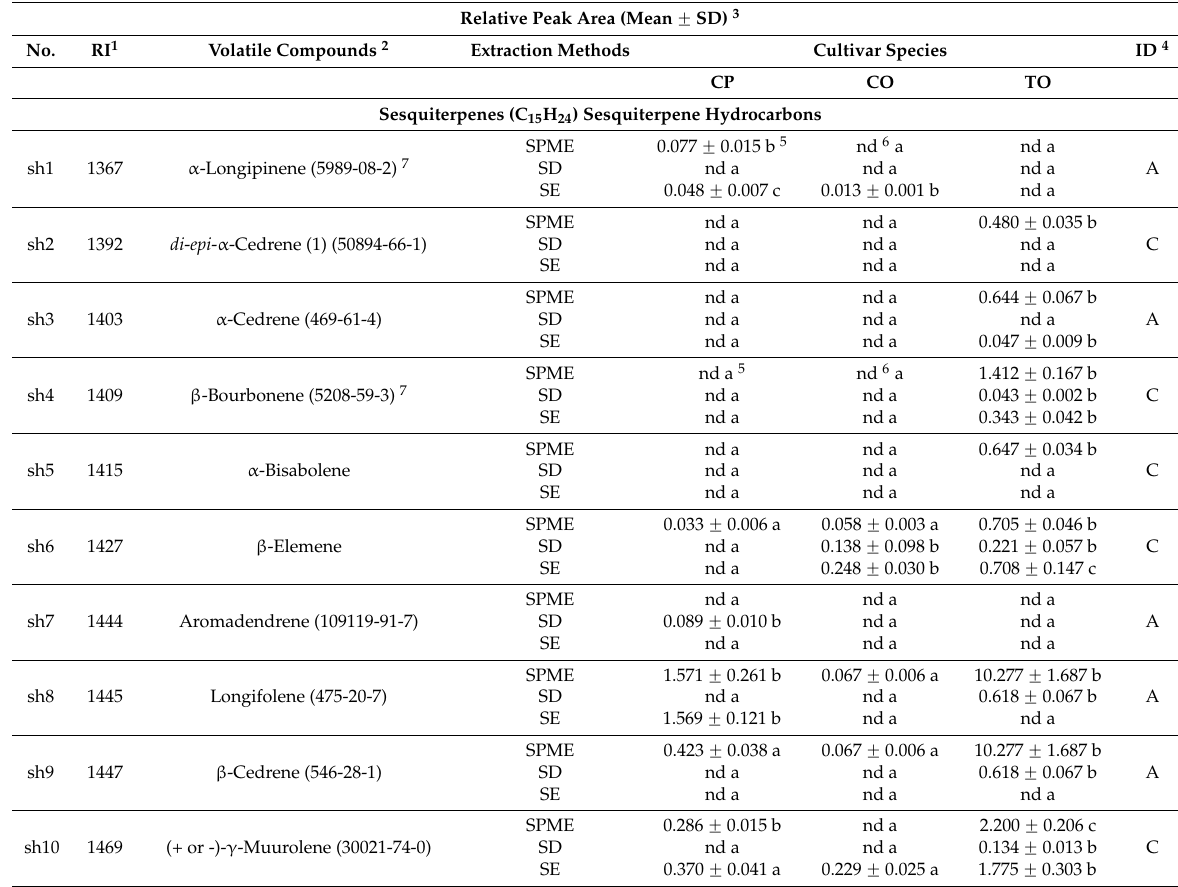
Table 3. Sesquiterpenes (Sesquiterpene hydrocarbons and oxygenated sesquiterpenes) and diterpenes of three different cultivars based on different extraction